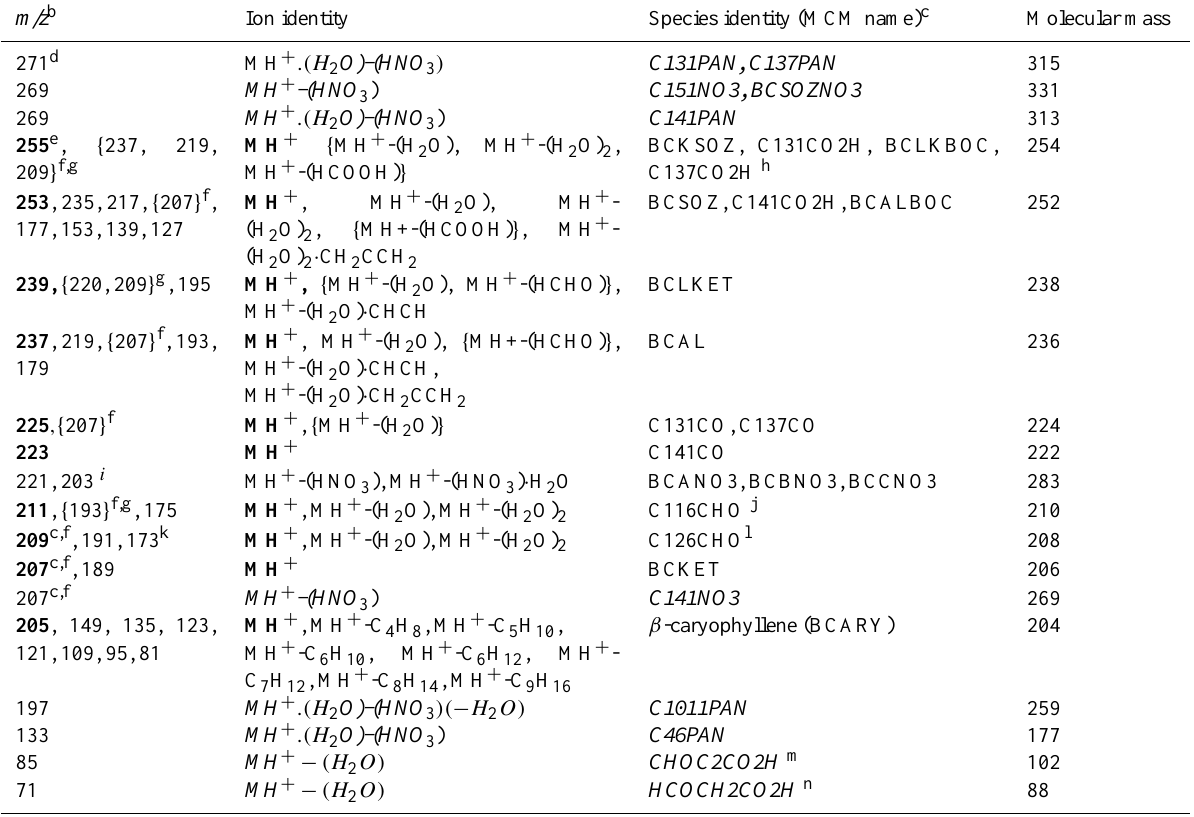
Table 3. Summary of ions detected using CIR-TOF-MS and their species assignments a